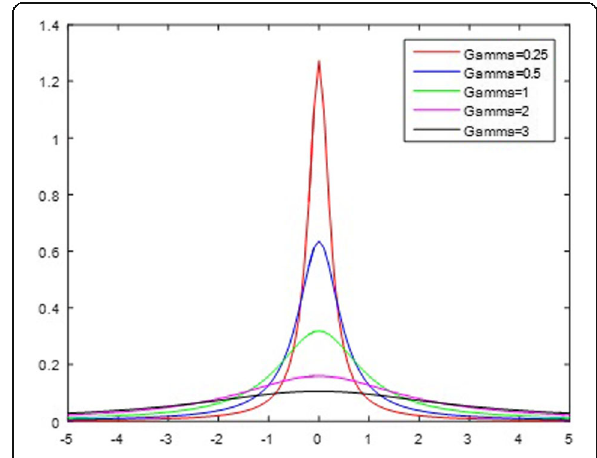
Fig. 2 Alpha-stable distribution for different values of α